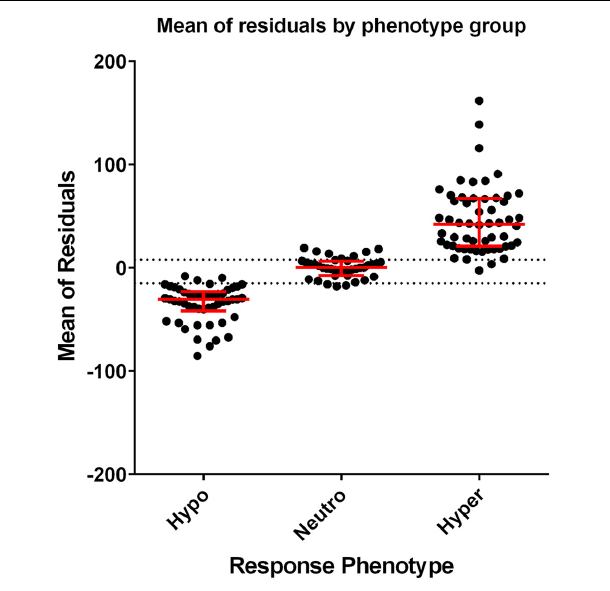
FIGURE 2 | Scatterplots of the individual mean of residuals grouped by response phenotype. Dots represent the mean of residuals from each profile included in analysis. Red lines represent the median and interquartile range of the data. The dotted lines (–15 and +8) show the tolerance level of defining the response phenotype (mean of residuals > +8 is classified as hyper-responsive, mean of residuals < –15 is classified as hypo-responsive, and ≥ –15 or ≤ +8 is classified as normo-responsive).